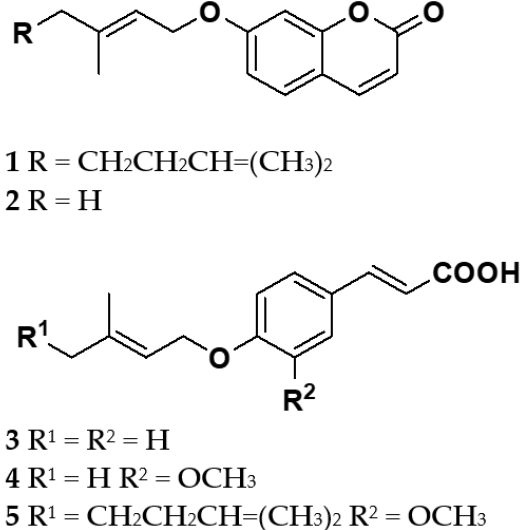
Figure 1. Structures of the phytochemicals under investigation. Compounds belong to two phe- nylpropanoids subclasses, such as O -prenylcoumarins ( 1 – 2 ), and cinnamic acid derivatives ( 3 – 5